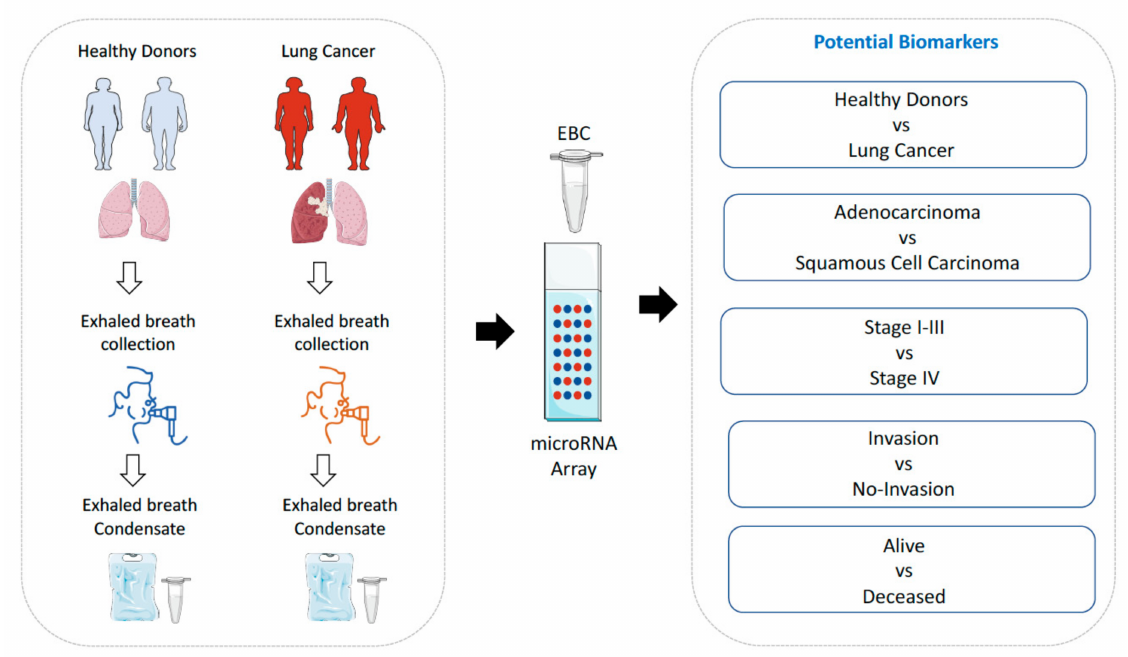
Figure 1. Overview of the study design. Genome-wide miRNA expression profiling was performed on exhaled breath condensate (EBC) from 21 healthy volunteers and 21 lung cancer patients. The utility of EBC miRNAs as biomarkers of diagnosis, type of tumor, stage, invasion capacity and prognosis was